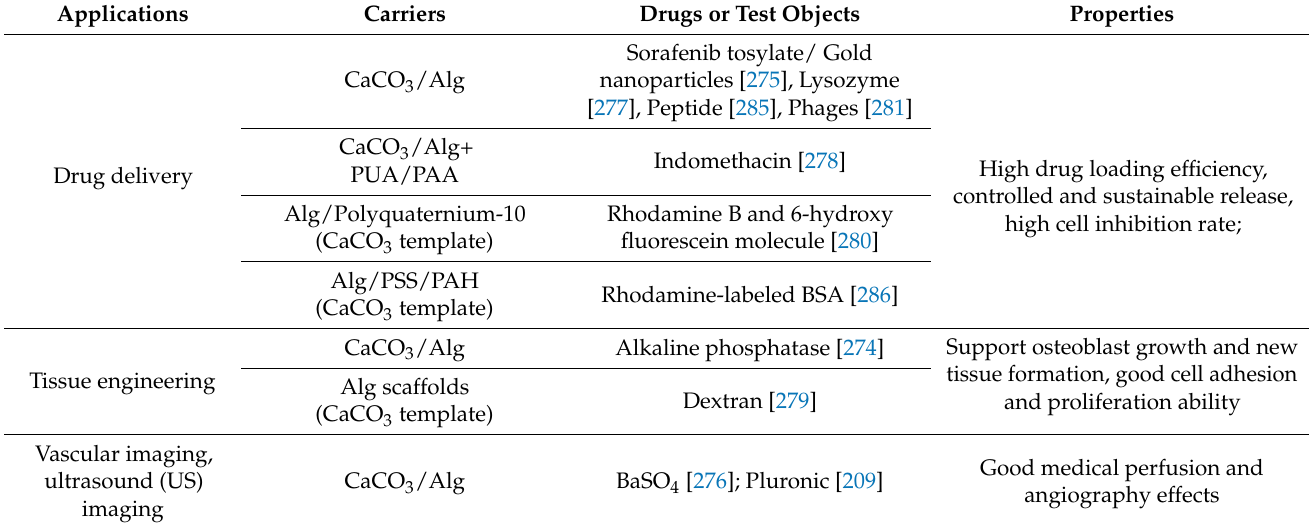
Table 7. Hybrid carriers based on a combination of CaCO 3 and Alg, their properties and